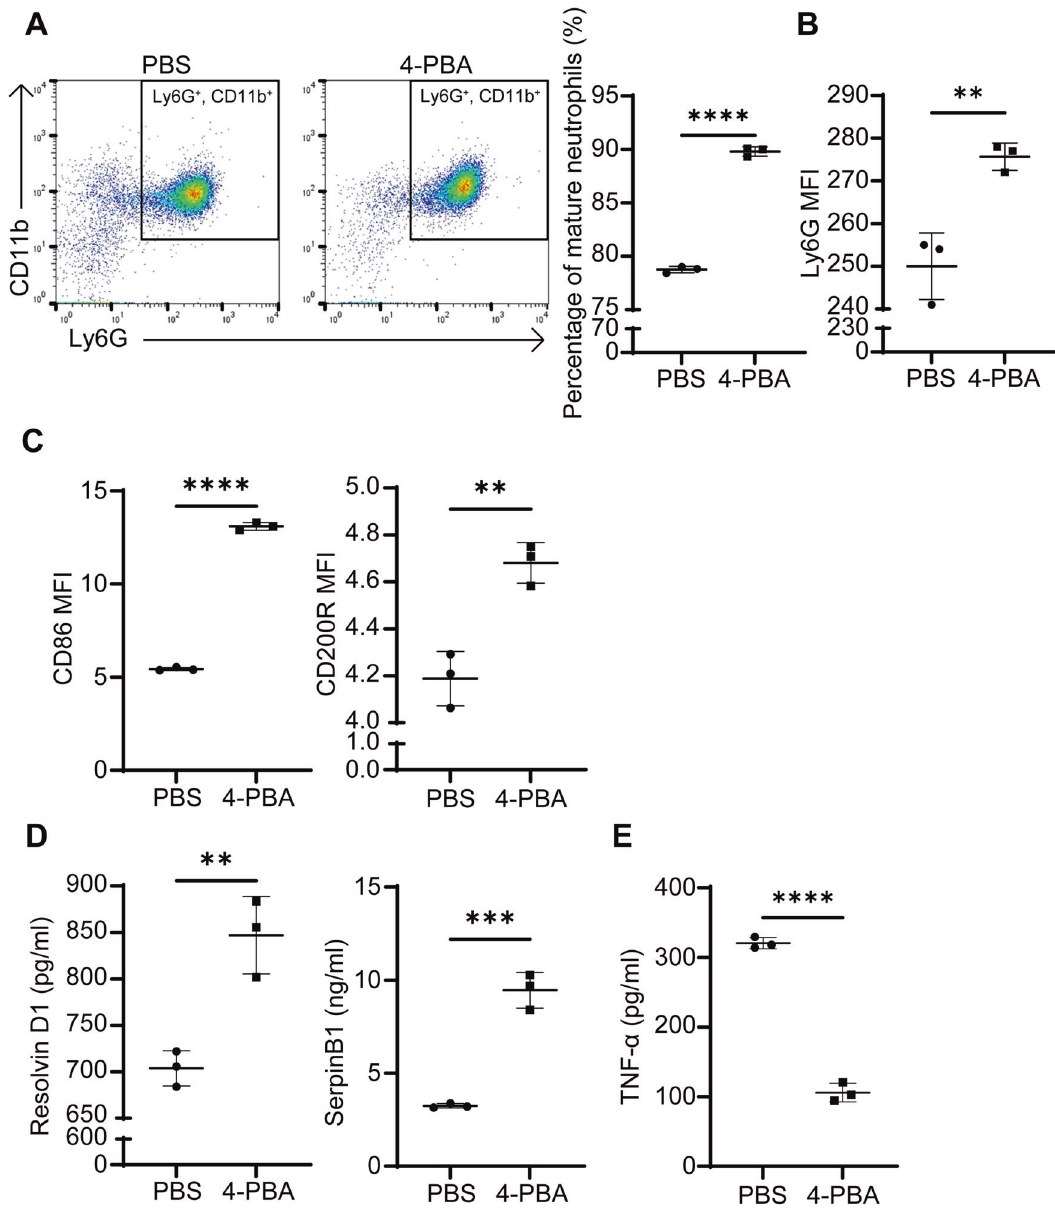
Fig. 2 Resolving neutrophils trained by 4-PBA express elevated levels of cell surface CD86/CD200R, increased RvD1/SerpinB1, and reduced TNF- α . A Flow analyses of mature Ly6G hi CD11b + neutrophils. WT neutrophils treated with PBS or 4-PBA (1 mM) for 24 hours were subjected to fl ow analyses and the percentages of Ly6G hi CD11b + neutrophils were plotted. ( n = 3). B The mean fl uorescent intensity (MFI) levels of Ly6G on WT neutrophils treated with PBS or 4-PBA (1 mM) for 24 hours ( n = 3). C The levels of CD86 and CD200R on WT neutrophils treated with PBS or 4-PBA (1 mM) for 24 hours ( n = 3). D The expression of RvD1 and SerpinB1 from WT neutrophils treated with PBS or 4-PBA (1 mM) for 24 hours ( n = 3). E The secretion of TNF - α from WT neutrophils treated with PBS or 4-PBA (1 mM) for 24 hours followed by PMA priming (100 ng/ml) for 30 min ( n = 3). Data plotted as mean ± SD. **** P < 0.0001, *** P < 0.001, ** P < 0.01 using two-sided Student ’ s t